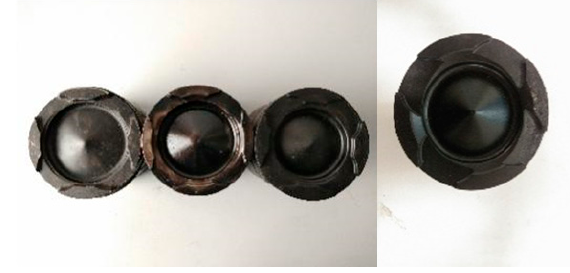
Figure 3. The images of RCSL ( left ) and RCTL ( right ). Table 4. Experimental schedule for different combustion chambers.